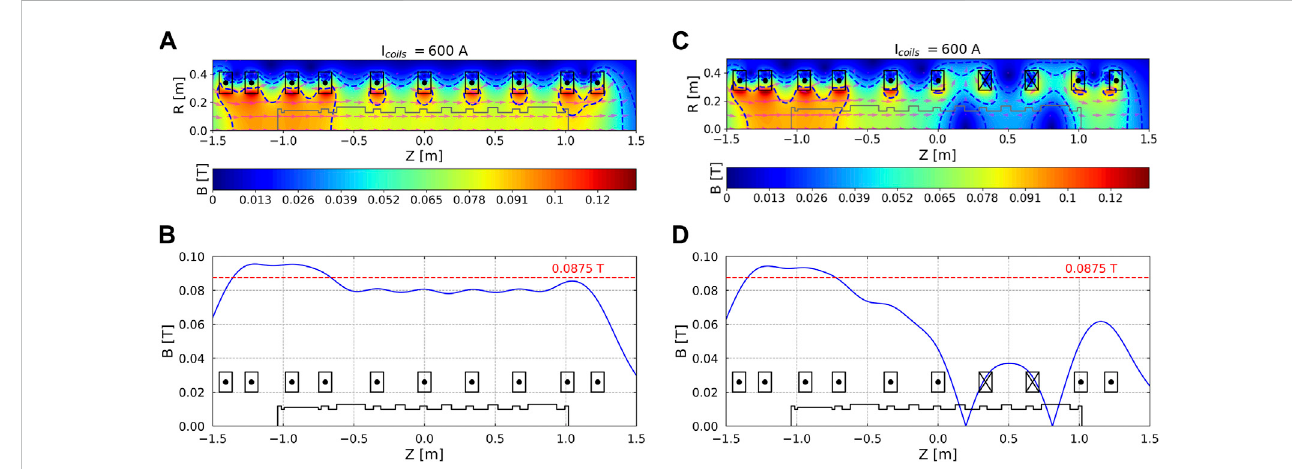
FIGURE 3 The two-dimensional distribution of (cid:1) B (A, C) and its value along the axis of GyM (B, D) , at I coils = 600 A, for the linear (A, B) and double cusp (C – D) magneticcon fi gurations.Schematicofthevesselandthemagnetic fi eldcoilsmayalsobeseen.Thelengthofthearrowsof fi gures (A,C) isproportionaltothe magnitude of (cid:1) B . The blue dashed lines of fi gures (A, C) and the red dashed lines of fi gures (B, D) represent the magnetic fi eld required for ECR at 2.45 GHz (87.5